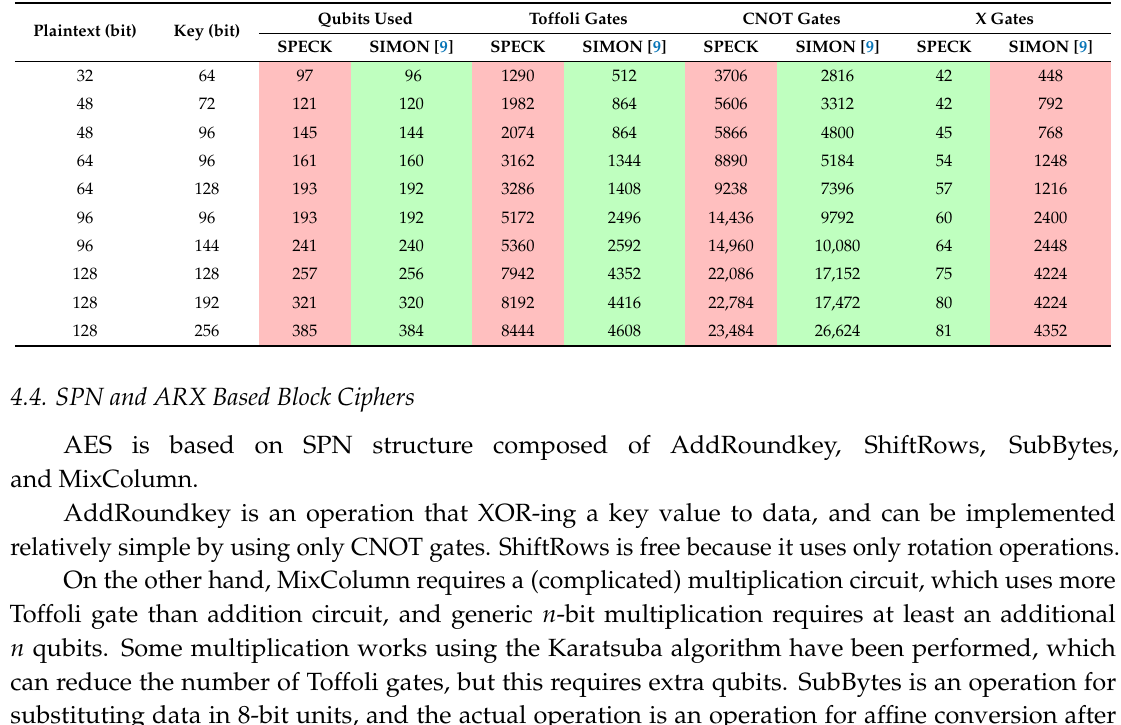
Table 7. Comparison between SPECK and SIMON in terms of quantum resources.